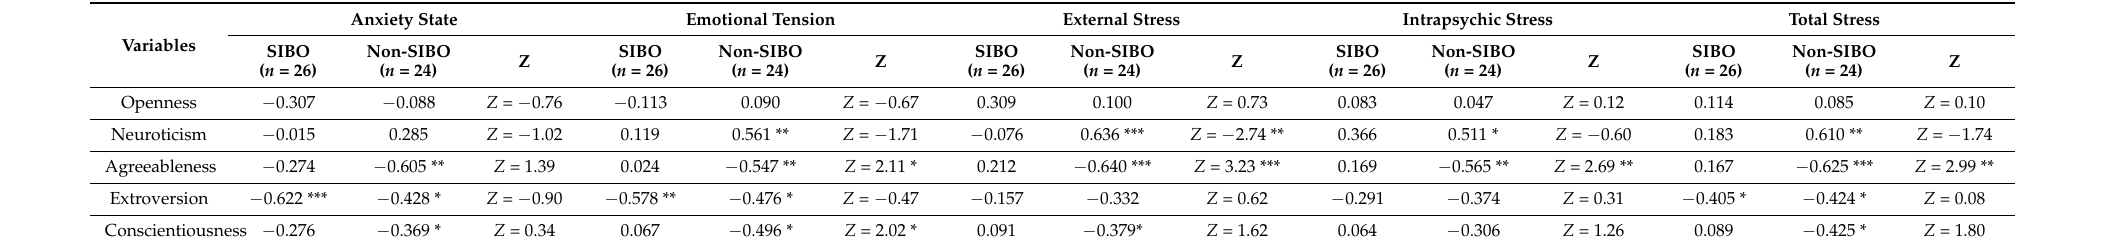
Table 3. Personality traits and stress correlations in two